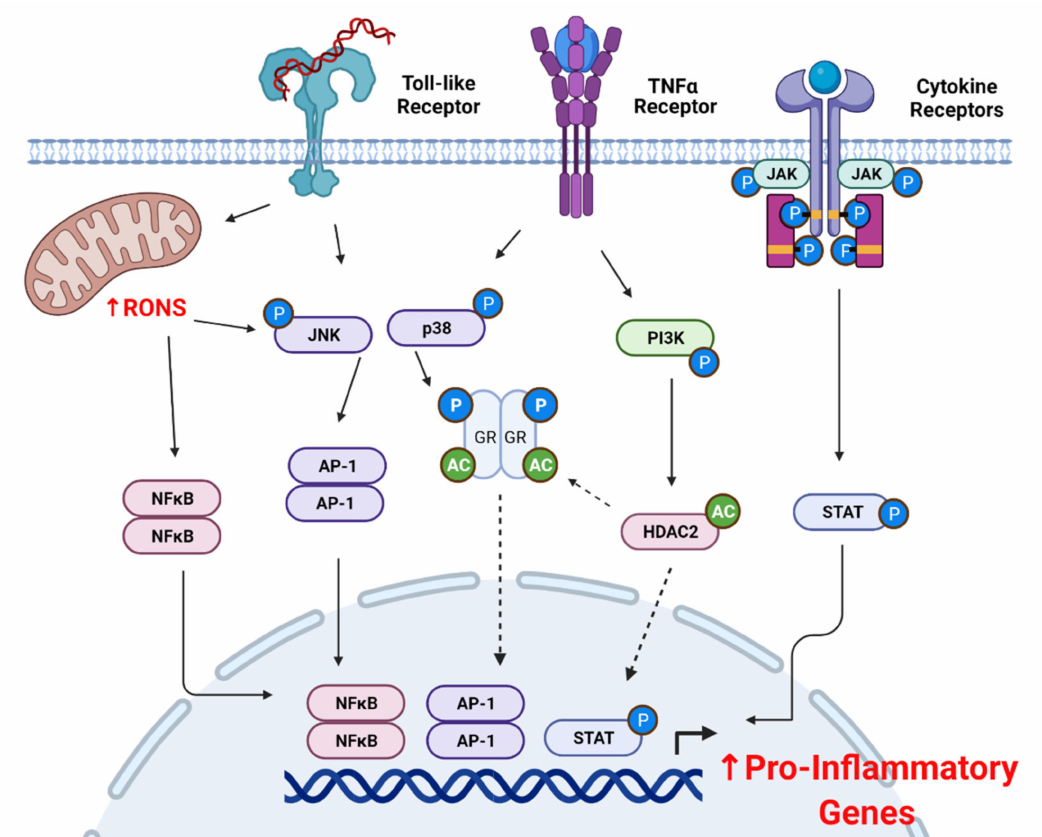
Figure 2. Reactive Oxygen Nitrogen Species (RONS) and Glucocorticoid receptor (GR) Signaling. The activation of pro- inflammatory signaling pathways (Tumor necrosis factor Receptor (TNFR), Toll-like Receptor, and Cytokine Receptors) leads to increases in RONS production in mitochondria and cytosol. Posttranslational modification such as acetylation and phosphorylation affect GR and HDAC2 activity, leading to augmented pro-inflammatory responses. Dashed arrows represent decreased activity and function. The figure was adapted from “B Regulatory Cell Surface Receptor Influences IL-10-mediated Immune Tolerance” (2021). Retrieved from https://app.biorender.com/biorender-templates (accessed on 27 July